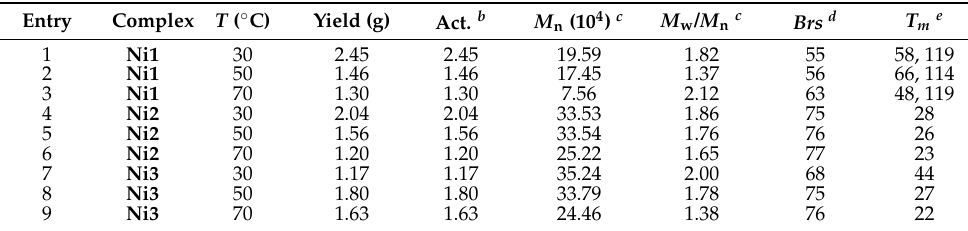
Table 1. Ethylene Polymerization a .